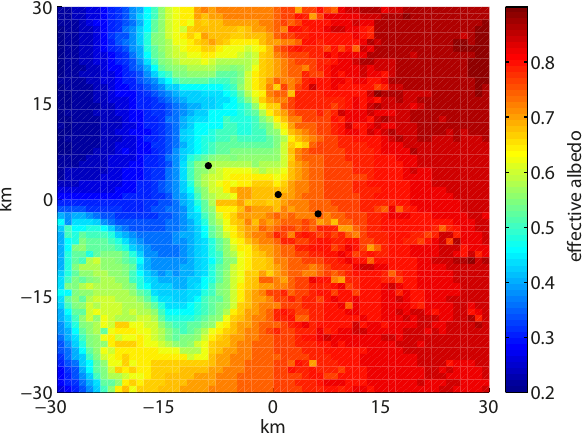
Figure 7. Effective albedo distribution around the measurement lo- cations (three dots) derived from modeled global irradiances of a 60km × 60km grid (“standard” scenario, SZA=62 ◦